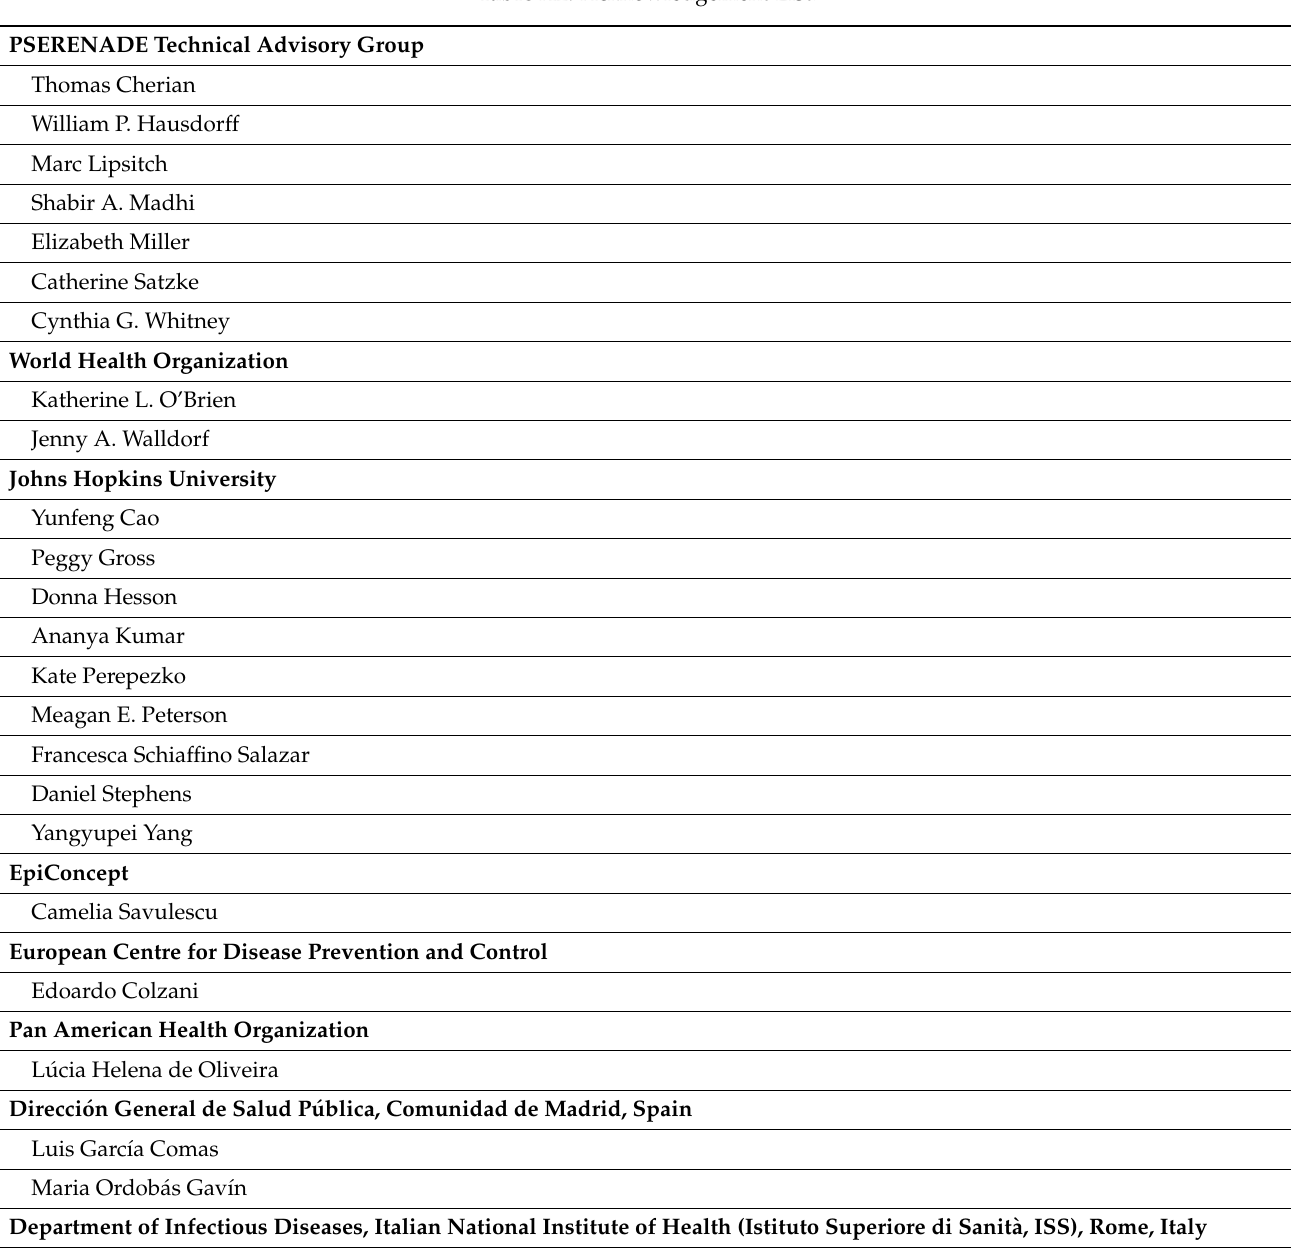
Table A2. Acknowledgement